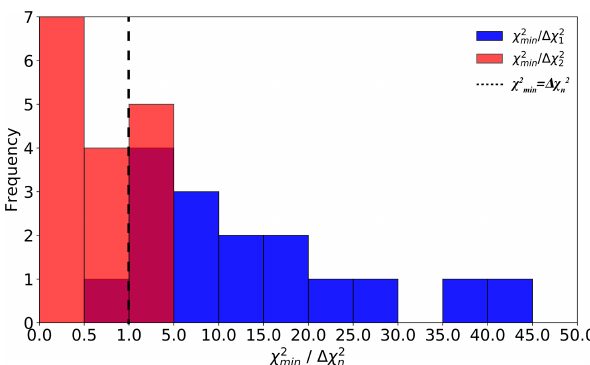
/(cid:49)χ 2 (blue shading) and χ 2 min 1 , (cid:49)χ 2 , and (cid:49)χ 2 are derived for each min 1 2